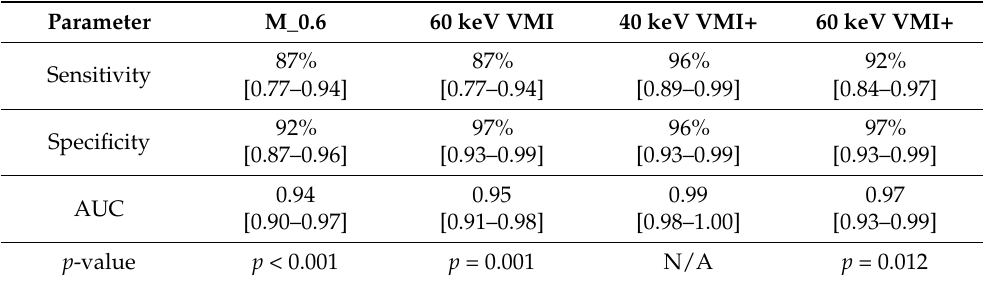
Table 4. Diagnostic performance of linearly blended M_0.6, standard virtual monoenergetic imaging (VMI) at 60 keV, and noise-optimized VMI+ series at 40 keV and 60 keV levels for the detection of portal vein thrombosis (PVT).